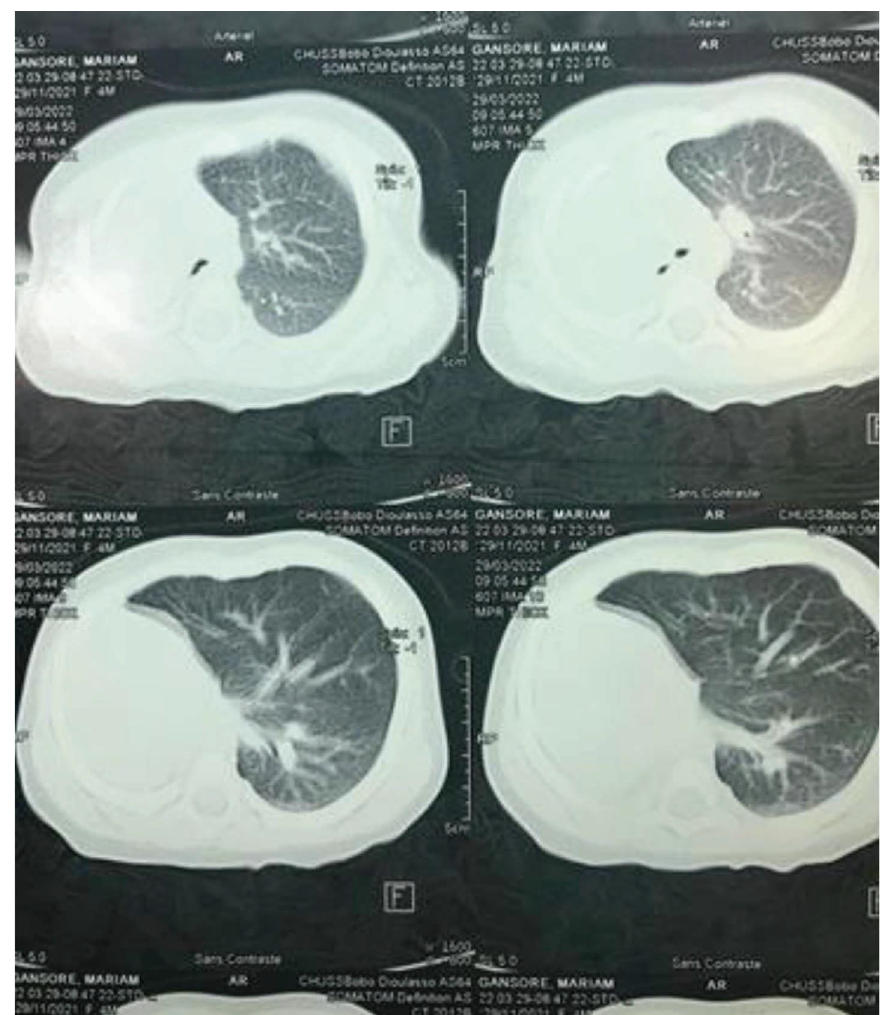
Figure 2: Chest CT scan in a 4-month-old infant showing agenesis of the right lung parenchyma, absence of a right stem bronchus, compensatory hypertrophy of the left lung, which extended to the right hemithorax, causing deviation of the mediastinum and responsible for dextrocardia, and a single left pulmonary